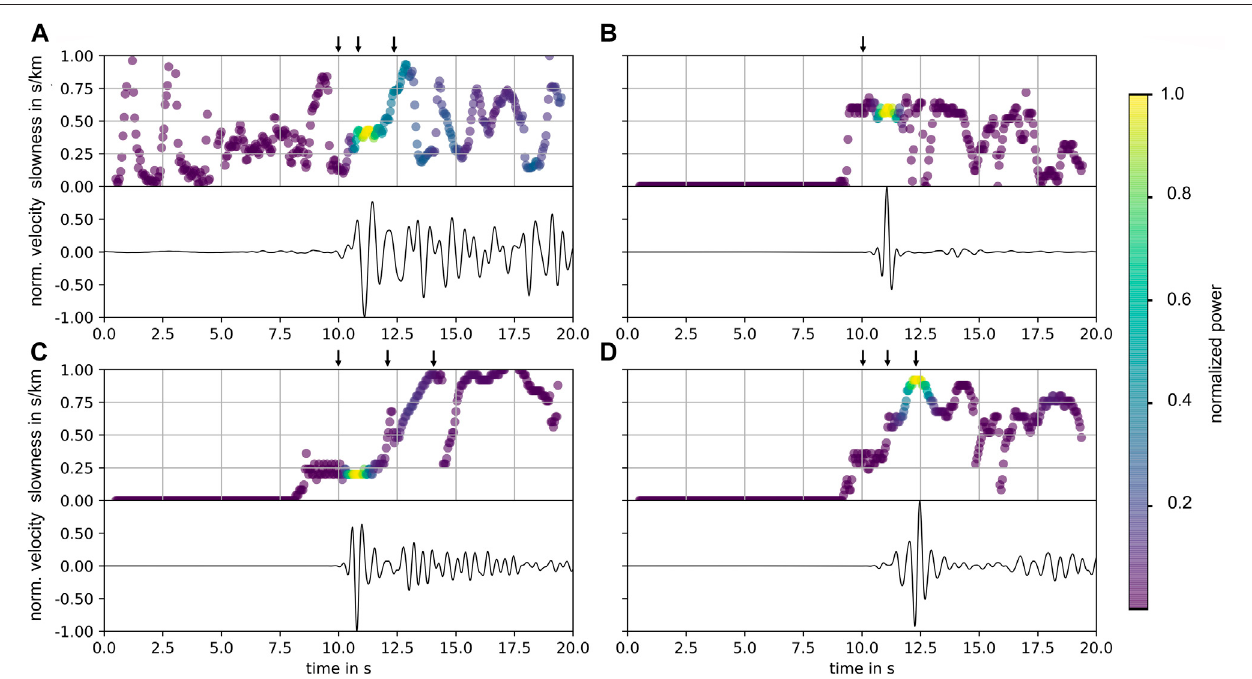
FIGURE9| Temporalslownessvariationofthemonitoreddata (A) togetherwiththevariationofthesynthetics (B,CandD) andthecorrespondingseismogramof the central array station. Both synthetics and monitored data are fi ltered between 0.125 and 3 Hz. The black arrows mark the onset of the seismic signal and further slowness steps. (A) Ground motion after 07.01.19 17:58:31, black arrows correspond to MS. (B) VSF in a depth of 200 m (model 2). (C) Explosion source in a depth of 1800 m (model 3) and (D) VSF in a depth of 200 m (model 3).